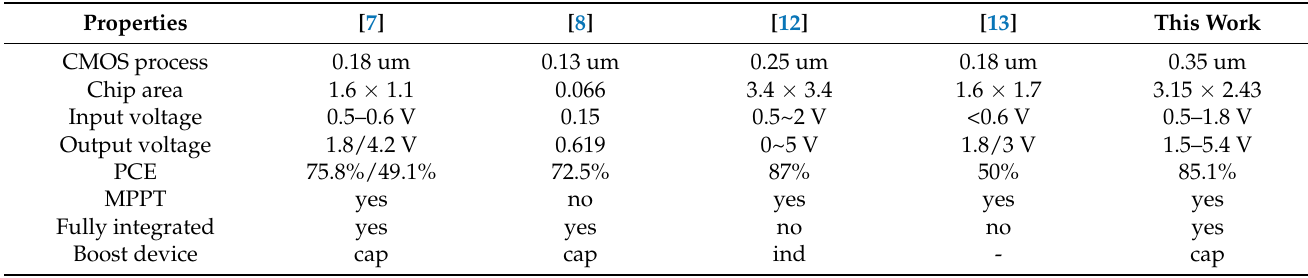
Table 2. Properties Summary and Comparison.